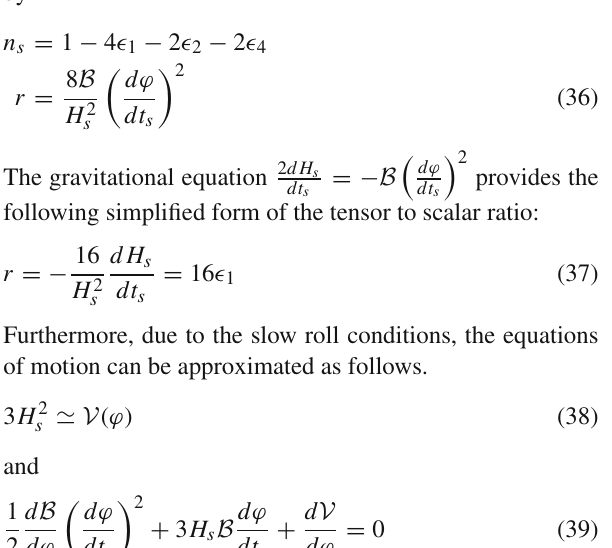
−√ 1 / 6 (cid:15)(ϕ) a (η) is